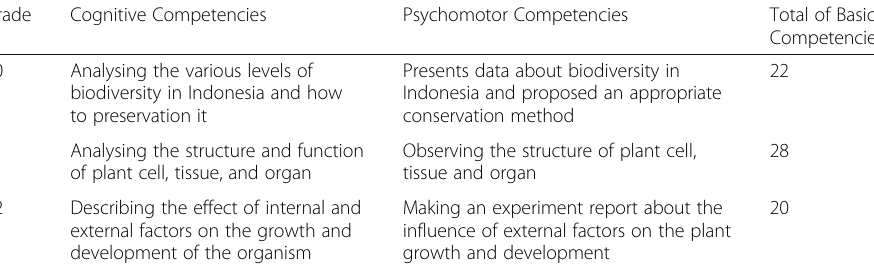
Competencies 22 28